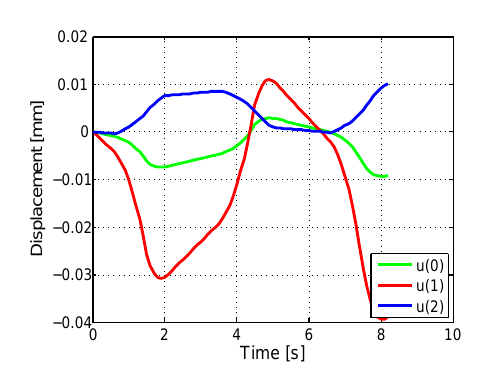
Figure 7. Displacement of point E in x , y and z directions according to time.